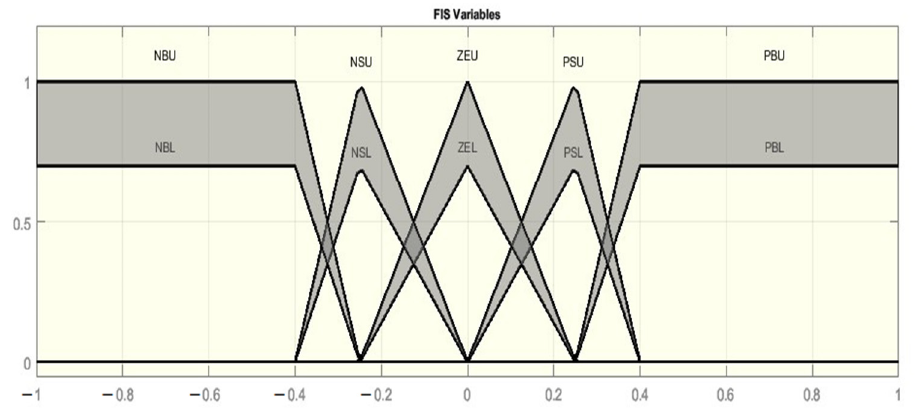
Figure 6. FIS variables of change in current (I). Table 2. Output FIS variables.